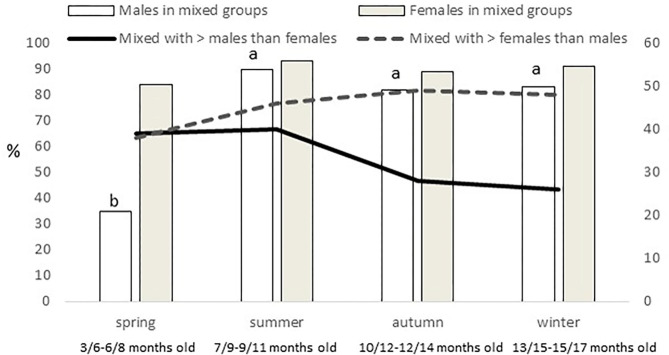
In the left axis and with bars, percentage of males and females out of the total of males and females observed found in mixed groups (groups with at least one male and female). In the right axis and with lines, percentage of mixed groups where more males than females are present and percentage of mixed groups where more females than males are present, observed for the different seasons (spring: March to May; summer: June to August; autumn: September to November and winter: December to February) in free-range Iberian pigs.